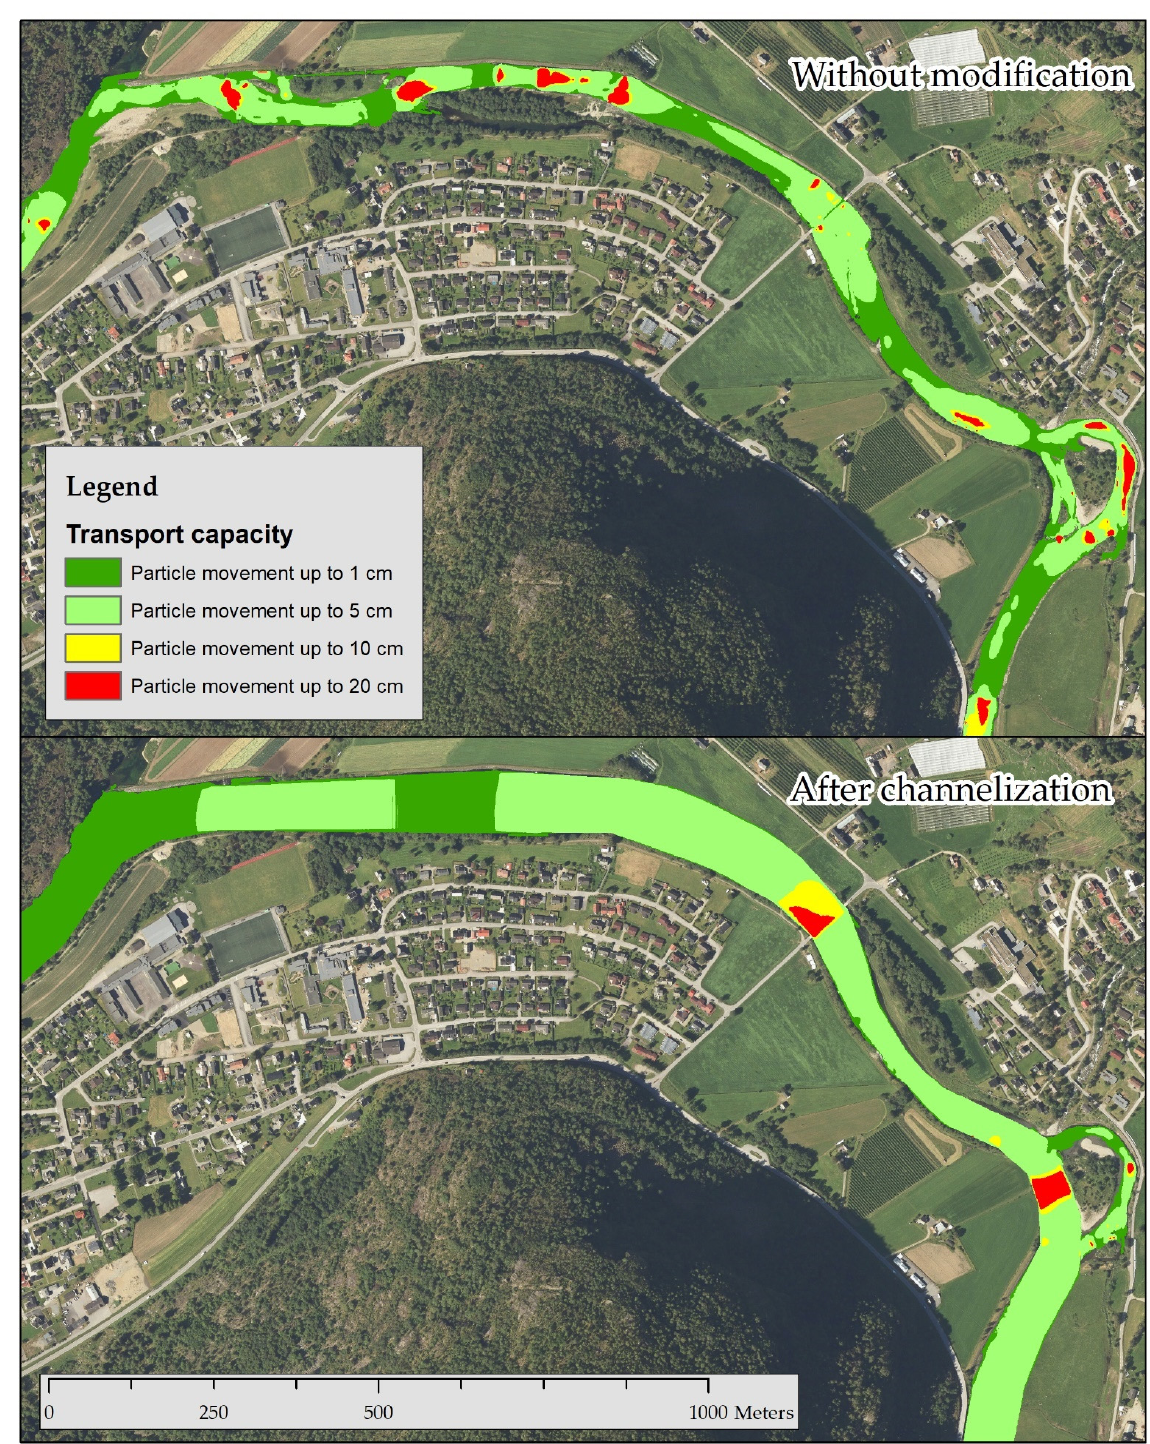
Figure 9. Map of particle movement according to shear stress with flow of 65 m 3 /s.